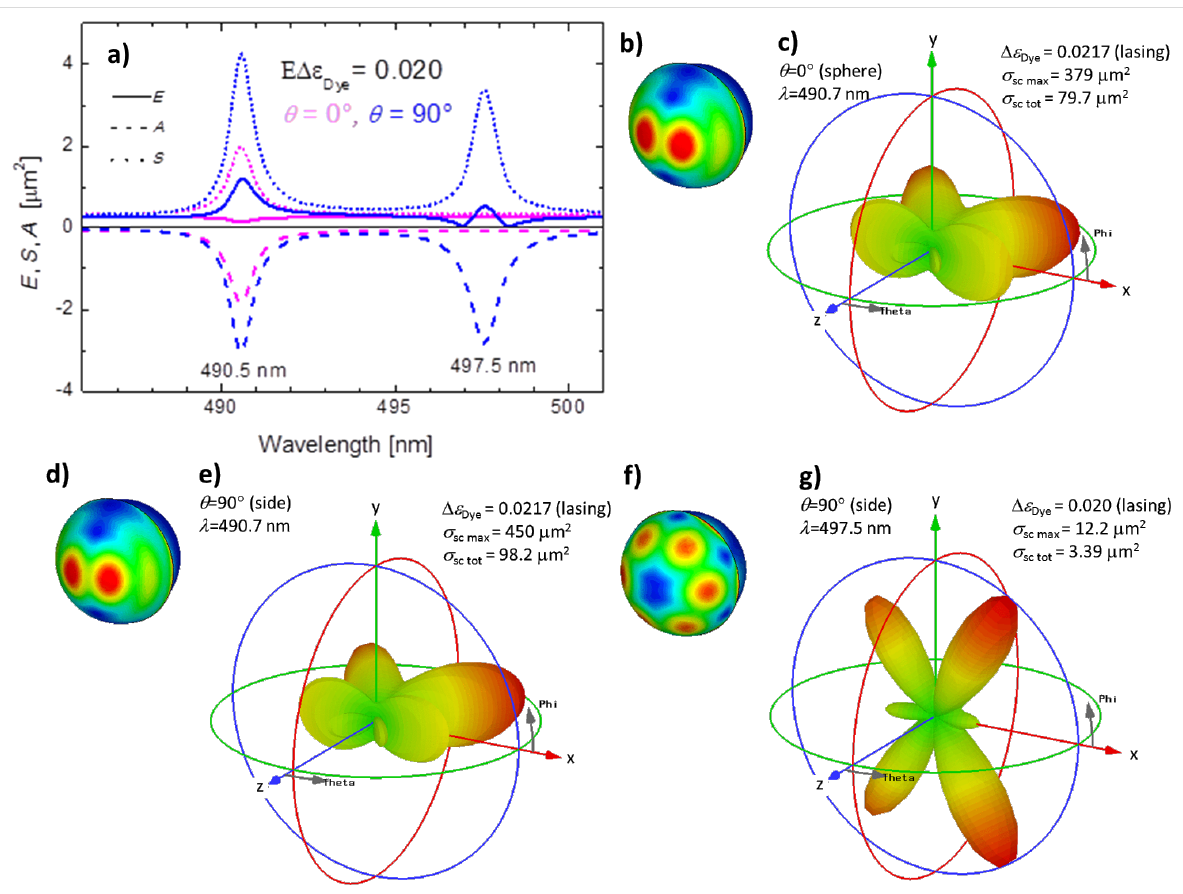
Figure 9: (a) Cross sections in case of a semi-shell of thickness h = 20 nm near the lasing threshold of Δε Dye = 0.020, A = 0, E = 1, extinction (solid lines), scattering (dotted lines) and absorption cross sections (dashed lines) for illumination from the (0,0) direction (magenta lines) or (90,0) direction (blue lines). (b–g) Near-field distribution and differential scattering cross sections; (b,c): for the 491 nm resonance and the (0,0) illumination; (d,e): for the 491 nm resonance and the (90,0) illumination; and (f,g): for the 497.5 nm resonances and (90,0) direction. Note that in the case of (b–e) Δε Dye = 0.0217 was used instead of 0.020 as in (a) and (f,g), see main text.